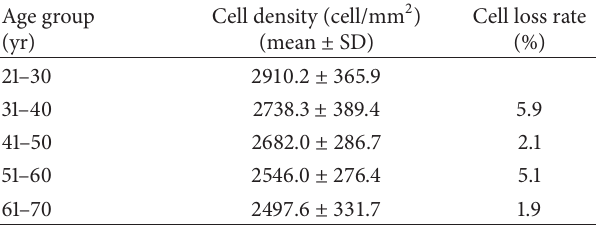
Table 4: Endothelial cell loss by decade of